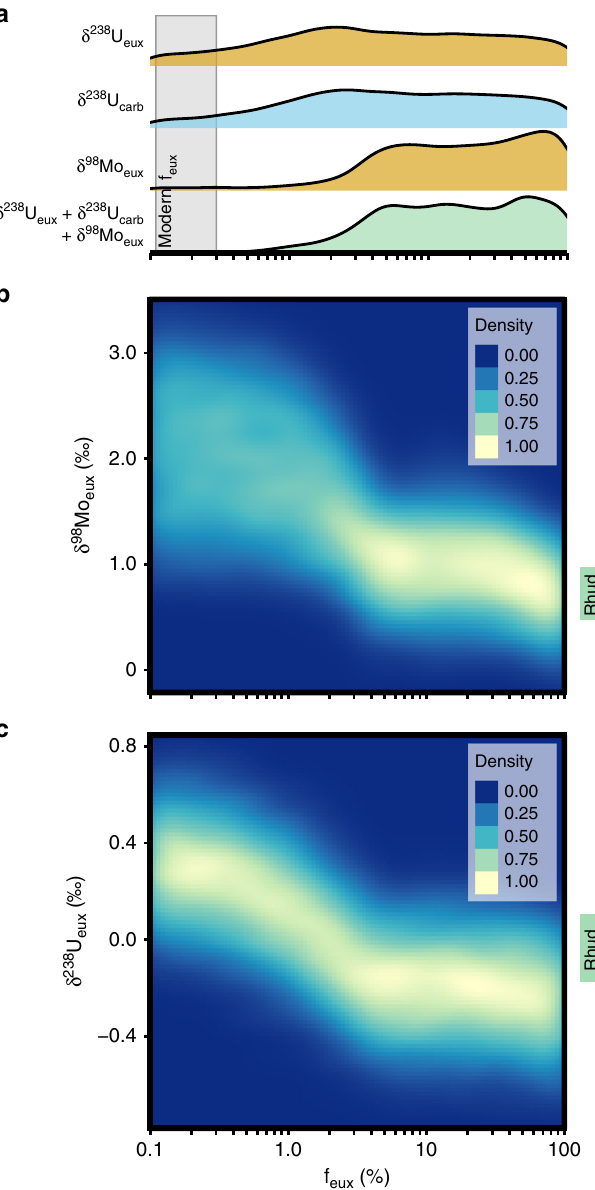
Fig. 2 Estimates of euxinia (f eux ) from Monte Carlo simulations. a Smoothed frequency distributions (upper panel) represent the distributions of f eux scenarios compatible with the measured δ 238 U eux , δ 238 U carb 8 , δ 98 Mo 8 and euxinic shale Mo-U isotope data eux , and combined carbonate ( δ 238 U eux + δ 238 U carb + δ 98 Mo eux ) (labeled, from top to bottom). The fully combined δ 238 U eux + δ 238 U carb + δ 98 Mo eux distribution is taken as the best- constrained model of f eux through this time interval. b Two-dimensional density plot shows the frequency distributions of modeled sedimentary δ 98 Mo eux , as calculated by global sensitivity analyses of the Mo isotope mass balance. c Two-dimensional density plot shows the frequency distributions of modeled sedimentary δ 238 U eux , as calculated by global sensitivity analyses of the U isotope mass balance. Green bars (right side of 2D density plots) illustrate the full range of Rhuddanian isotope